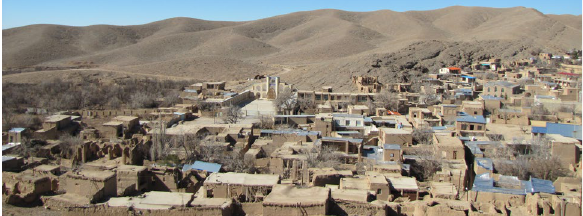
Figure 2. Village texture (the view from the top of the citadel remains),